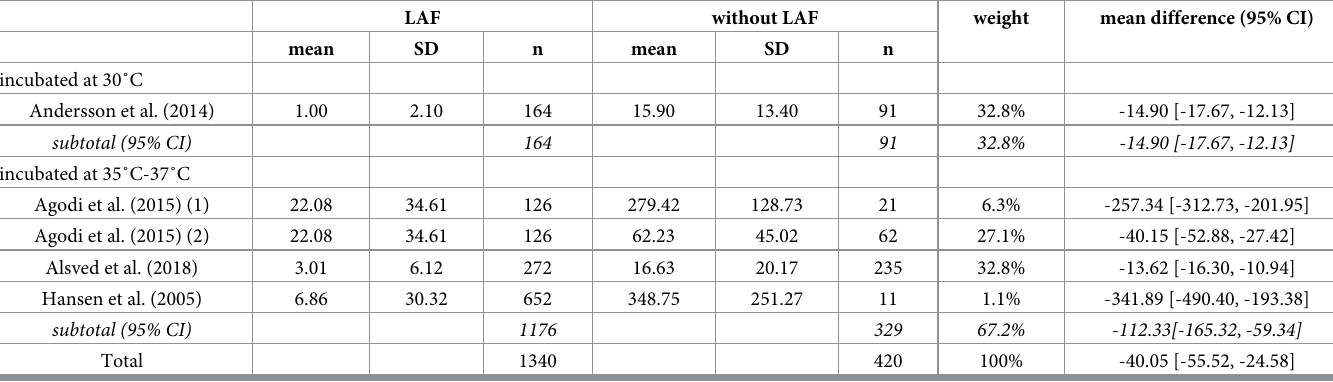
Test for heterogeneity showed very high inconsistency between the studies (I 2 = 96%). Test for publication bias p = 0.086.